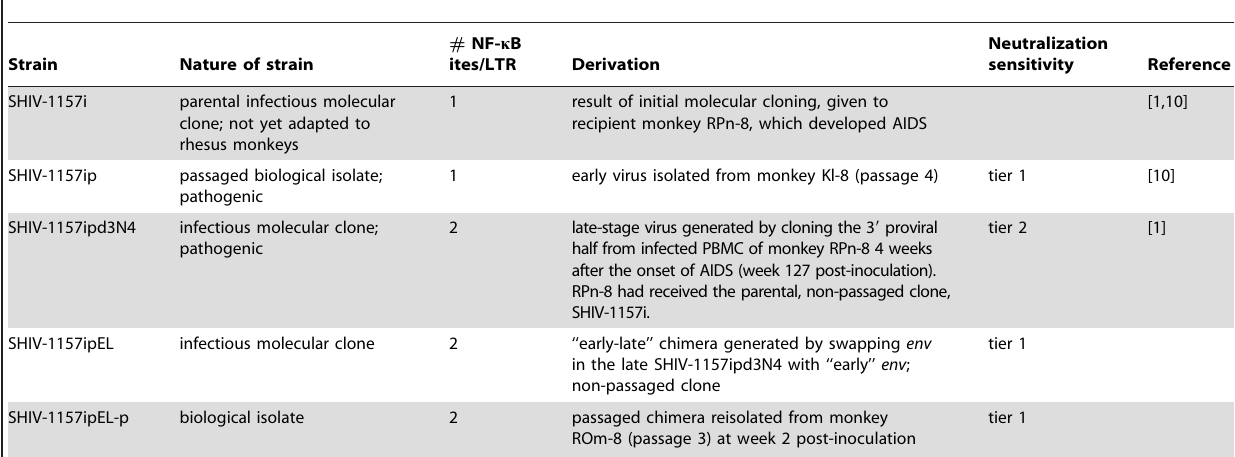
Table 1. Summary of R5 SHIV-C strains encoding an HIV1157i-related